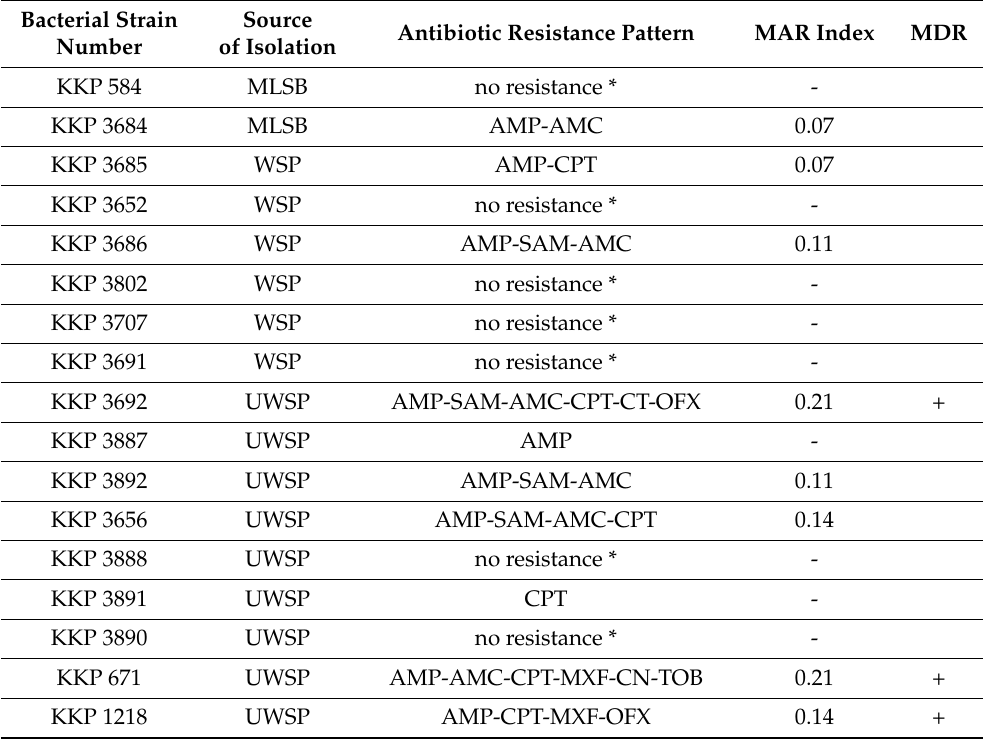
Antibiotic Resistance